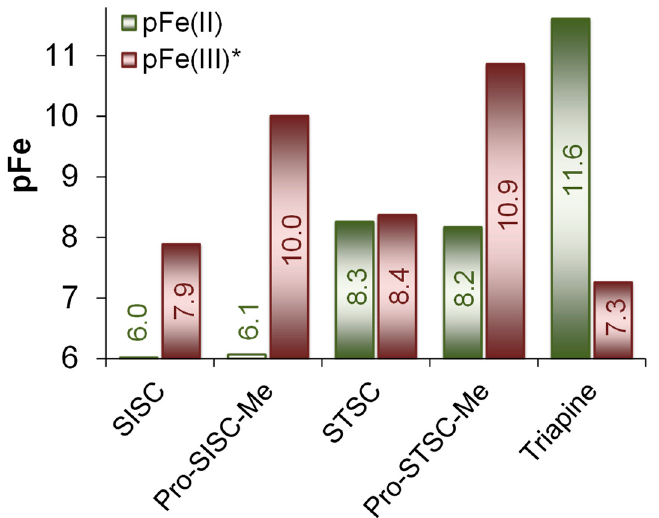
Figure 10. Fe(II)- and Fe(III)-binding affinity of SISC and Pro-SISC-Me compared to some related TSCs. pFe(II) ( − log[Fe(II)]) and pFe(III)* ( − log Σ [Fe(III) i (OH) j ]) values calculated at pH 7.4 at c Fe = 1 µM and c ligand = 10 µM. ((30% ( v / v ) DMSO/H 2 O; T = 25 ◦ C, I = 0.10 M (KCl)) Values for STSC, Pro-STSC-Me and Triapine complexes are calculated on the basis of the overall stability constants reported in Refs. [22,27,34].